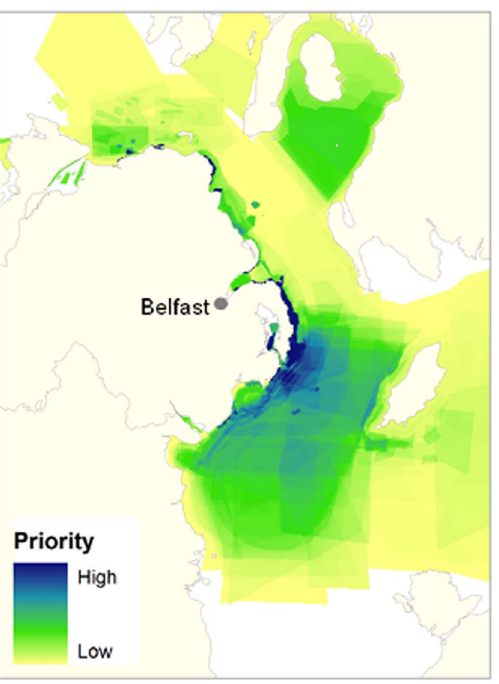
Figure 8. Map of the spatial access priorities of the Northern Irish fishing fleet. Map of the spatial access priorities of the Northern Irish fishing fleet generated from data obtained from 103 interviews with skippers and boat owners in 2012. It shows the main areas used by the fleet. There are a number vessels that have a much greater range than this. All areas were included in mapping process; however, for the purpose of maintaining an appropriate scale for visual display, they have not been shown.